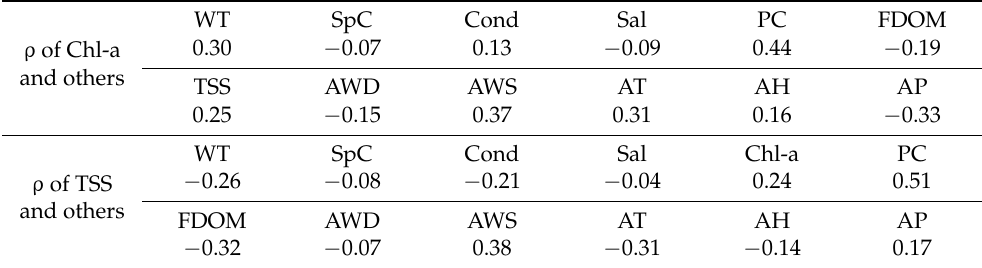
Table 5. Correlation analysis of the available variables WT, SpC, Cond, Sal, PC, FDOM, AWD, AWS,